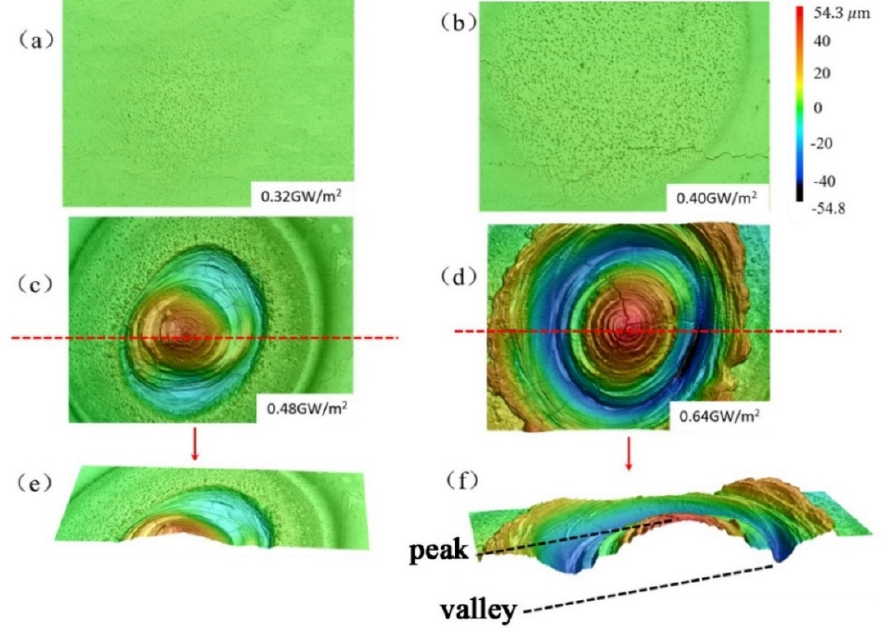
9 of 18 Figure 6. The local surface morphologies corresponding to the Figure 5 ( a–h ): rolled samples ( a – d ); fully recrystallized samples ( e – h ). Figure 7 shows the 3D height color map of the fully recrystallized samples under laser thermal shock with different power densities, observing that the higher the power density, the more apparent the fluctuation of the surface. As shown in the heightmap, a bulge formed in the center of the molten zone with the increased power density. Under the circumstances of higher thermal shock power density, the heat-loading region of the sample melts. Then, a molten pool is generated, and the edge of it rises because of surface tension. Next, molten tungsten converges from the edge to the center because of counter- acting force and starts to fluctuate. Finally, after laser thermal shock, molten W solidifies as it gathers from the edge to the center [35,36]. Figure 8 presents the variation of the maximum and minimum height values of the thermal shock surface with the increased power density, showing that the power density of 0.40 GW/m 2 is a dividing line. The high-